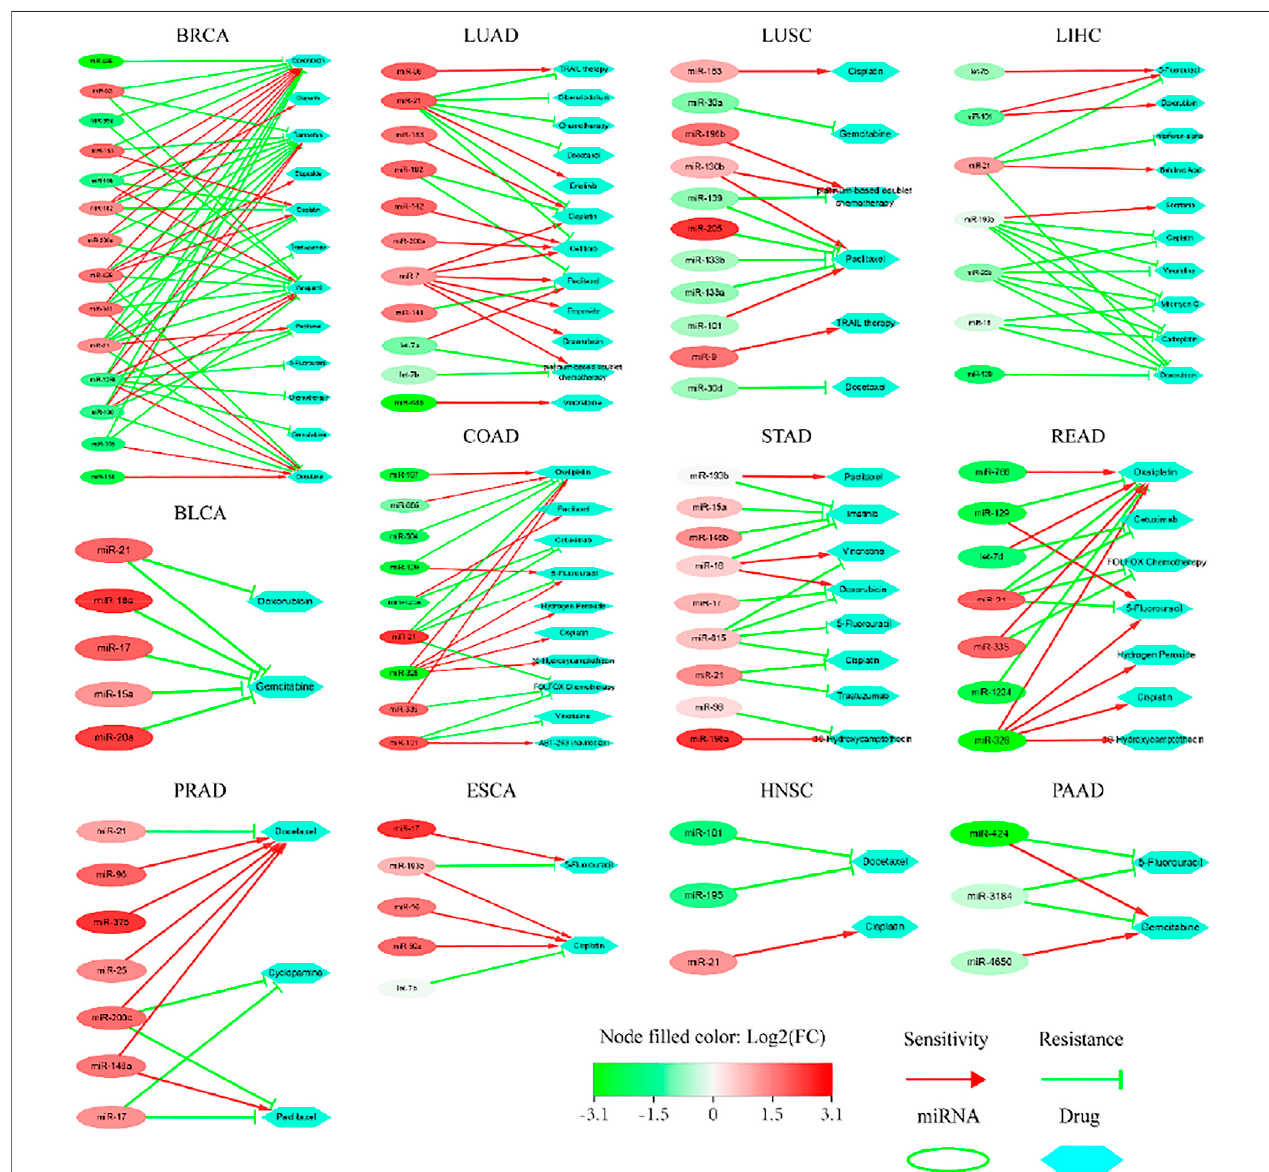
FIGURE 7 | Sensitivity or resistance to anti-cancer drugs by the top-20 ranked miRNAs extracted from the TCGA datasets of 20 types of cancer.